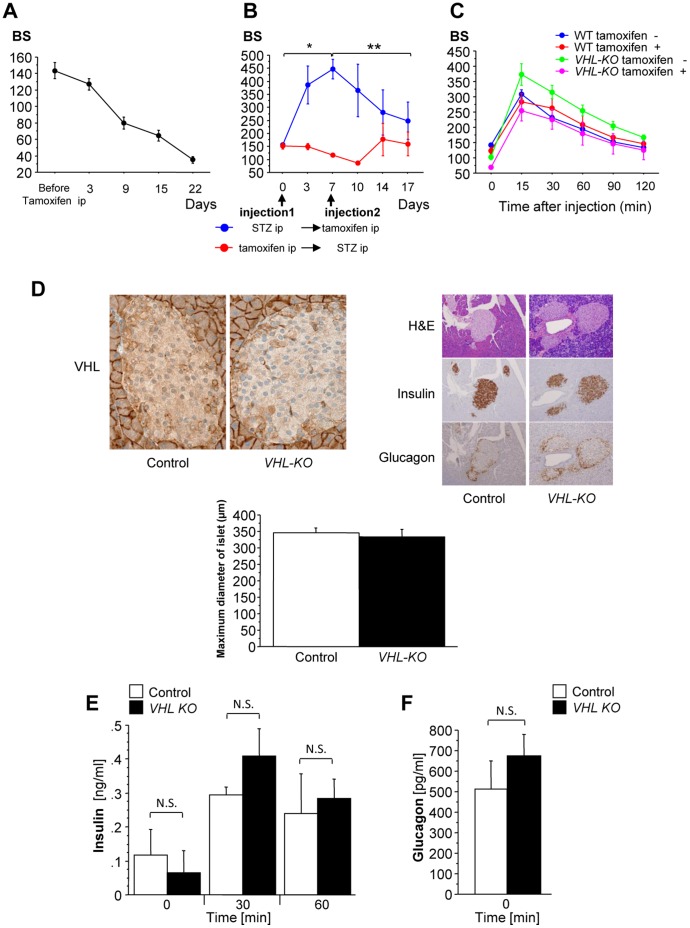

VHL-KO mice exhibit hypoglycemia despite normal glucose tolerance and intact pancreatic β cells.(A) VHL-KO mice had significant decreases in blood glucose levels (BS) after tamoxifen injection (4 mg/mouse; n = 10). (B) VHL-KO mice were treated with streptozotocin (STZ) before or after VHL-knockdown (n = 4 per group). Before tamoxifen injection, STZ treated mice (blue line) had significant increases in BS compared with their pre-STZ-blood glucose levels. After tamoxifen injection, their BS gradually decreased (day 0 vs. day 7, *p = 0.0057; day 7 vs. day 17, **p = 0.036). The mice treated with STZ after tamoxifen injection (red line) did not show any significant increases in blood glucose levels throughout the experiment. (C) VHL-KO mice (VHL-KO tamoxifen +) had glucose tolerance results comparable to that of other mice (WT tamoxifen +/− and VHL-KO tamoxifen −): WT tamoxifen −, n = 11; WT tamoxifen +, n = 10; VHL-KO tamoxifen −, n = 11; VHL-KO tamoxifen +, n = 7. (D) Histopathological images of pancreatic tissues showed that the immunoreactivity patterns for insulin and glucagon and morphological changes were not affected by VHL deletion with comparable maximum diameters of islets between control (VHL-KO tamoxifen −) and VHL-KO mice. (E) Glucose tolerance tests showed similar trends in insulin concentrations between VHL-KO and control mice (n = 5 per group, Time 0 min, p = 0.773:N.S.; 30 min, p = 0.294: N.S.; 60 min, p>0.9999: N.S.). (F) Basal glucagon levels were comparable between VHL-KO and control mice (p = 0.465: N.S.).